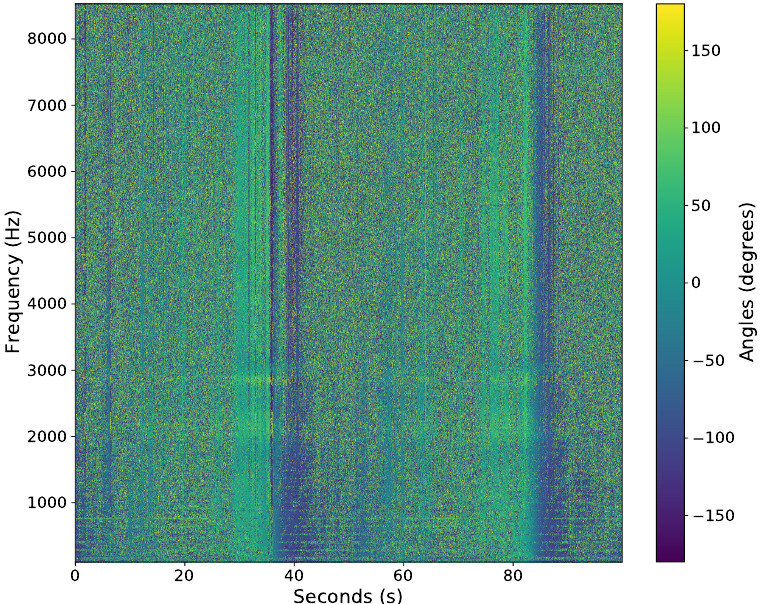
Figure 7. Azigram response from a single AVS of a snowmobile driving past the AVS at roughly 40 and 85 s.